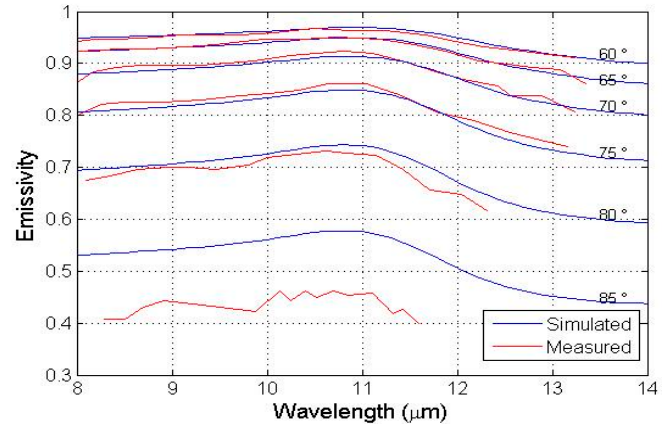
Figure 7. Comparison between simulated emissivity spectra and those measured by Branch et al. [33] at different angles. Table 2. The bias and RMSD values associated with the simulated sea surface emissivity spectra with respect to in situ measurements.